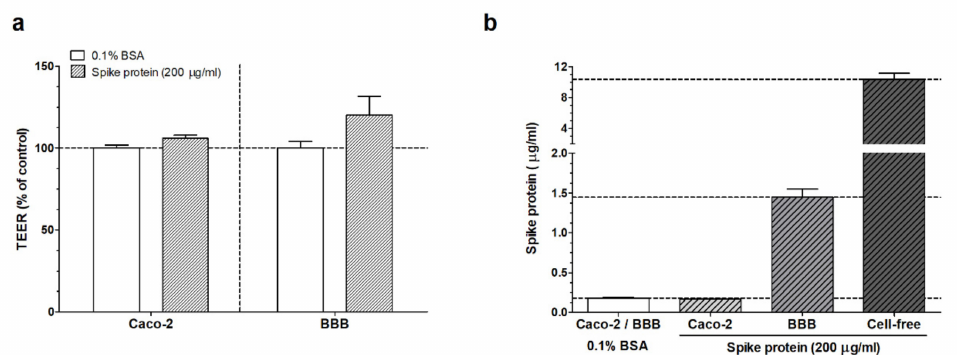
Figure 4. ( a ) Results of the transendothelial–transepithelial electrical resistance (TEER) measurement after SARS-CoV-2 spike protein (200 µ g/mL) treatment in 0.1% bovine serum albumin (BSA)–Ringer– HEPES buffer or only after buffer treatment (0.1% BSA). ( b ) Detection of spike protein S1 subunit by ELISA in samples from the bottom compartment of cell culture inserts after spike protein treatment (200 µ g/mL, 30 min). We also indicate results for inserts, which received only the carrier buffer (0.1% BSA) or the results of passage of spike protein across cell-free inserts. Caco-2: human intestinal epithelial cells. BBB: blood–brain barrier